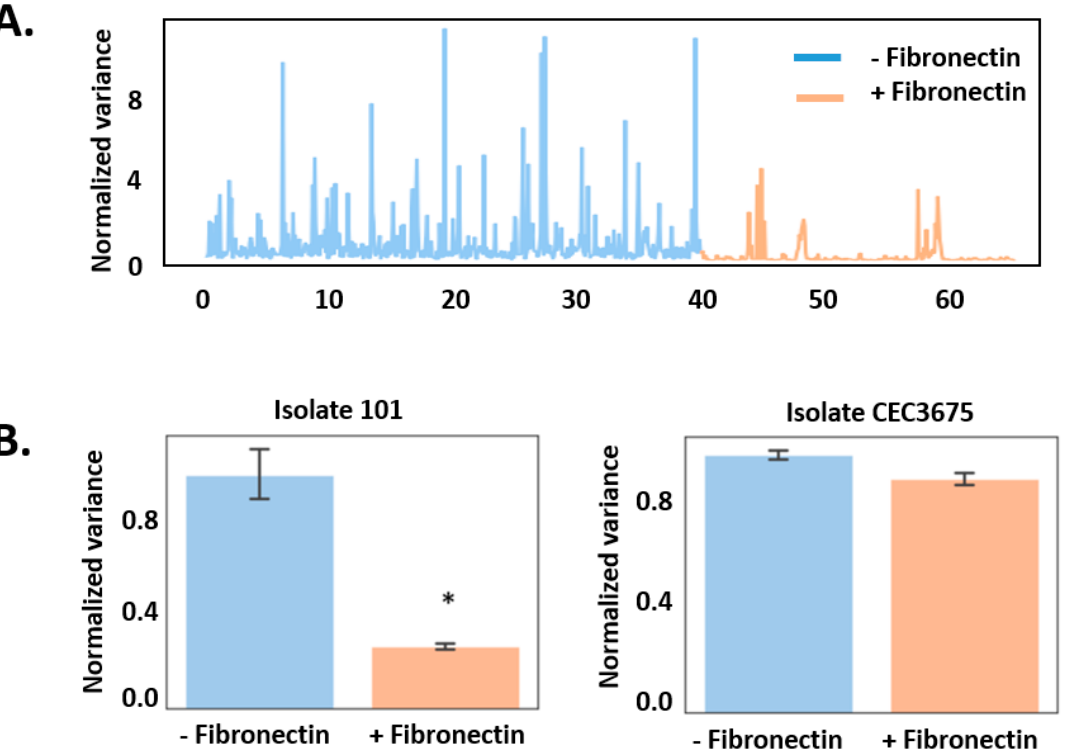
Figure 3. C. albicans isolate 101 and CEC 3675 react differently to fibronectin. ( A ). Representative graph of the normalized variance of isolate 101 in YPD (blue) and in YPD with fibronectin (orange). The decrease of the normalized variance is clearly visible between the two conditions. ( B ). The mean of the normalized variance (experiment in triplicate) represented as a bar plot for isolate 101 compared to isolate CEC 3675. Error bars are the confidence of intervals. Statistical analyses were done using Mann–Whitney U test, the asterisk represents p < 0.05.